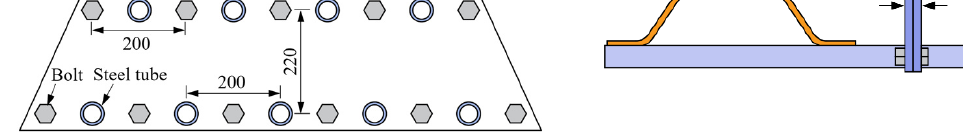
Figure 6. Structural parameters of the end-plate joint.